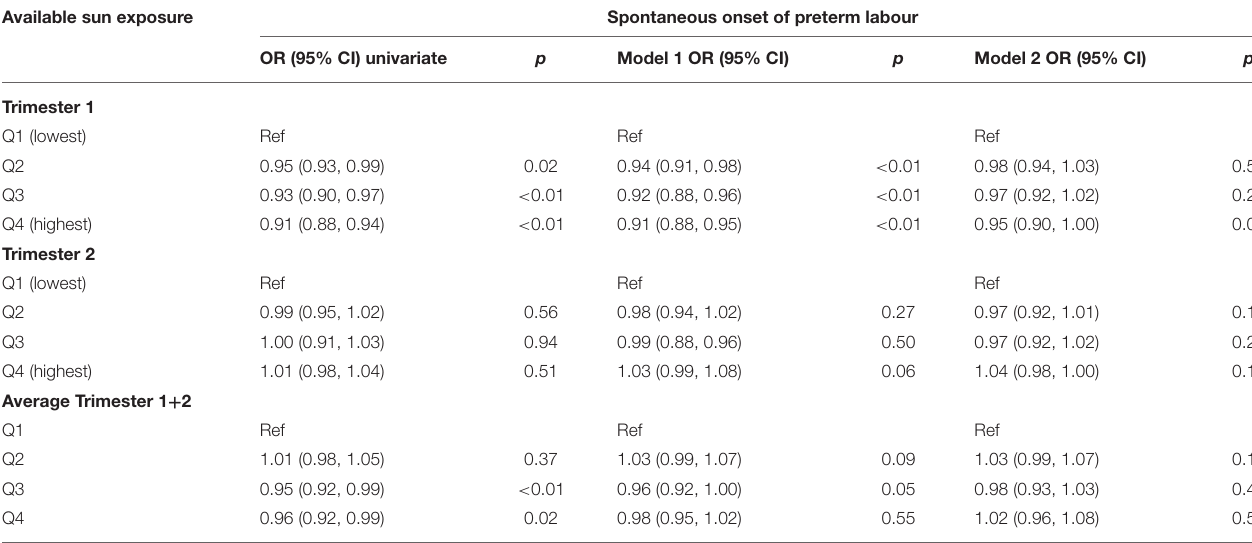
TABLE 4 | Association between mean sun hours per day available in trimester 1 and 2 and the combined average exposure over trimester 1 and 2 and spontaneous onset of preterm labour in Scotland 2000–2010. Available sun